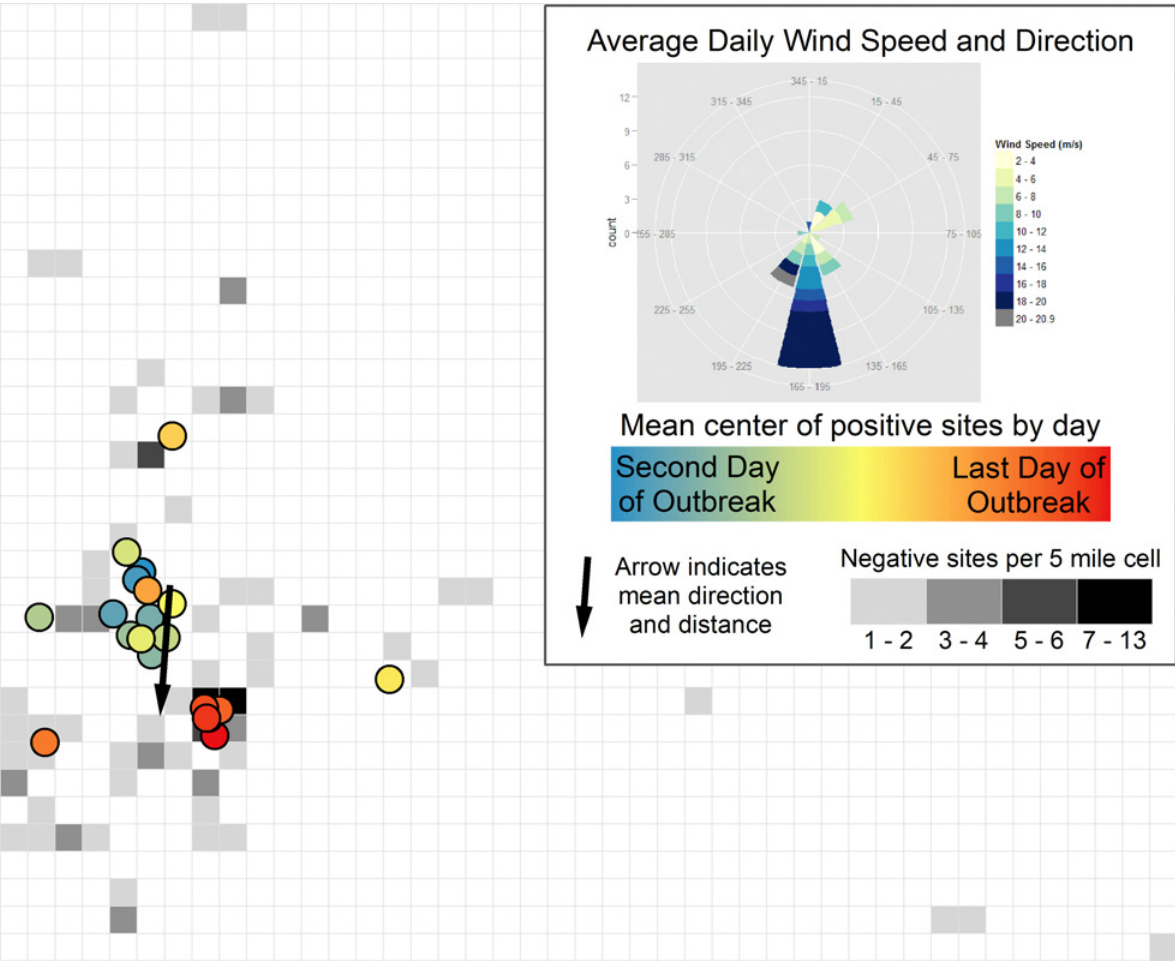
Fig 5. Direction of wind and disease spread during a Spring 2013 porcine epidemic diarrhea virus (PEDv) outbreak. The box on the upper right side of the figure summarizes wind data for the entire outbreak period, and the left side of the figure summarizes results from the linear directional-mean analysis for the direction of disease spread. On the left side, each colored circle represents the mean geographic center for all incident cases on a given day. The blue circles are earlier dates in the outbreak, and the red circles are later dates in the outbreak. The gray squares show locations of sites that remained negative for PEDv; each square measures 5 by 5 miles. Squares with a darker gray color have more negative sites in the area. The black arrow on the left side is the overall direction of disease spread from the linear directional-mean analysis. The mean direction of spread during the entire outbreak was south at 184.2 degrees (measured clockwise from due north), and the mean distance of spread was 19.3